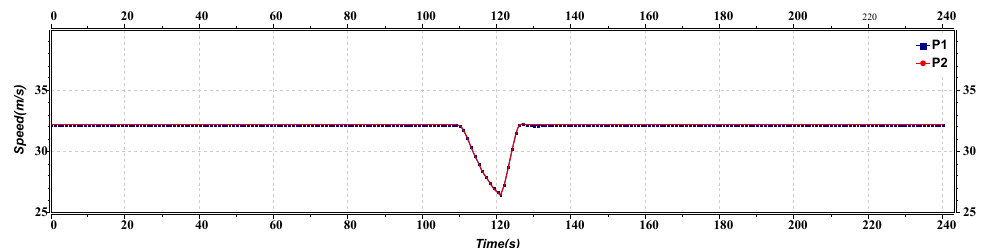
Figure 12. Speed versus time graph of lane change. Figure 13 represents the platoon leaders’ acceleration versus the time of lane